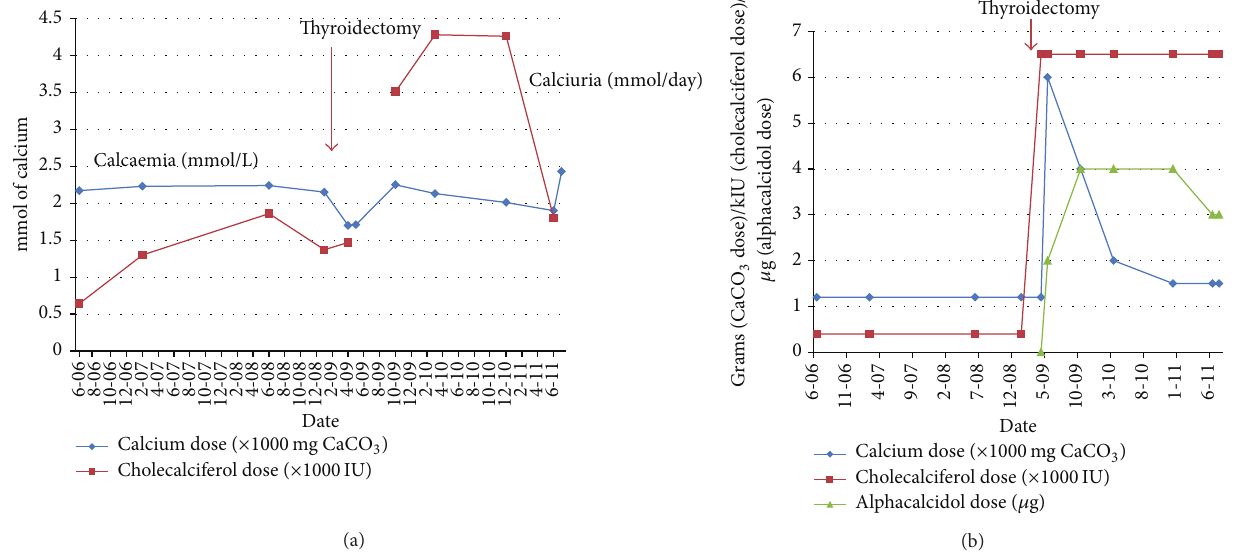
Figure 2: Calcaemia and calciuria in the perioperative period (a). Supplementation with calcium and vitamin D in this period (b). y axis shows a time line with specified datums of the measurements in the year of thyroidectomy (2009) .